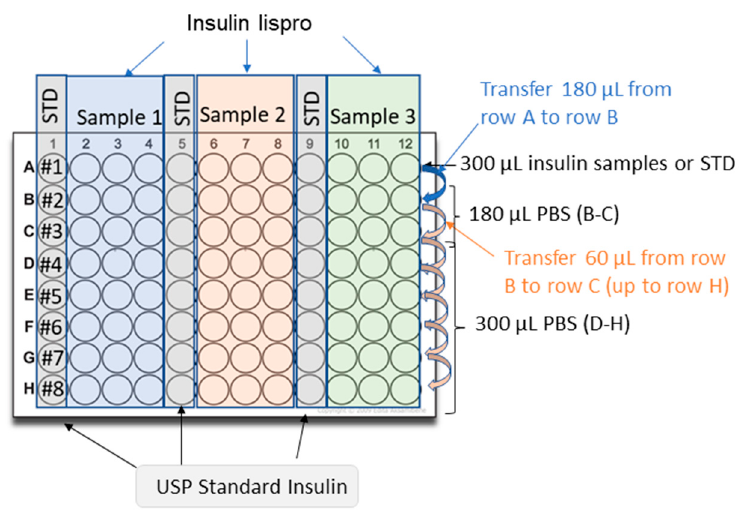
Figure 3. Schematic representation of the preparation of the dilution plates containing insulin lispro’s standards and samples.